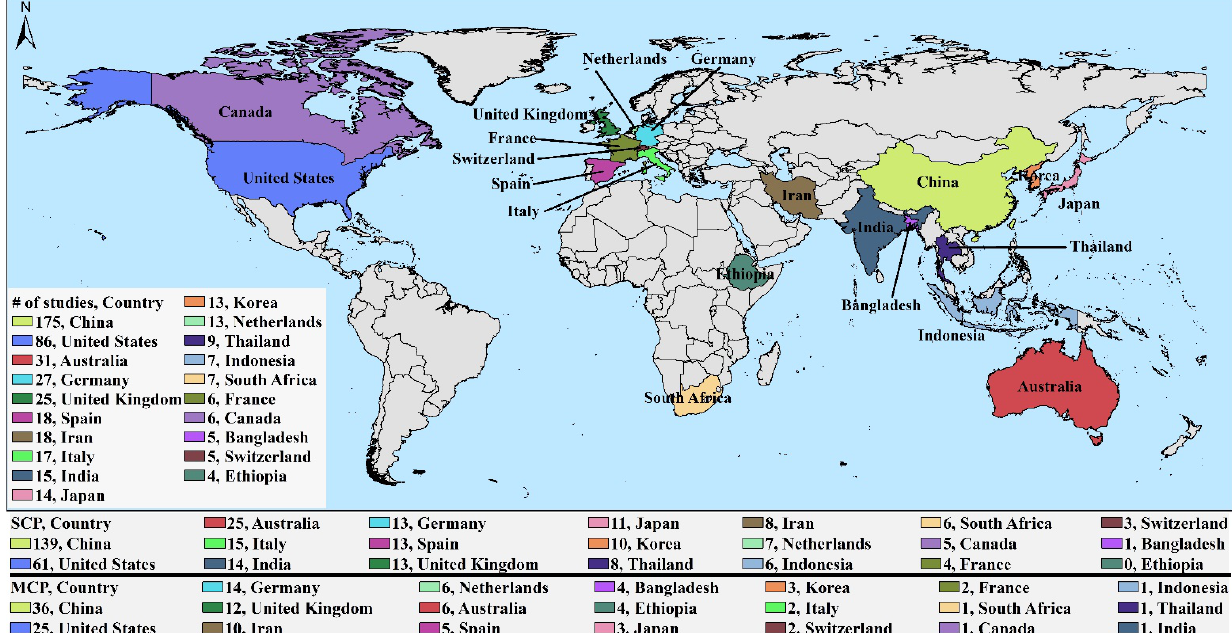
Figure 10. Geographical distribution of the top 20 countries based on the number of publications, SCP, and MCP on DR.